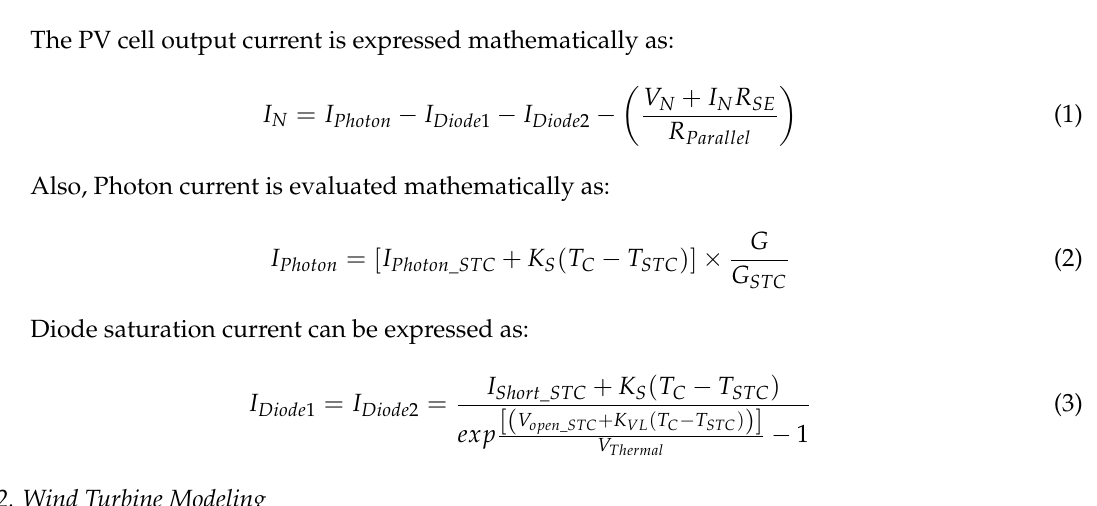
Figure 2. Equivalent circuit model of a PV cell with double diodes and a series and parallel resistance.